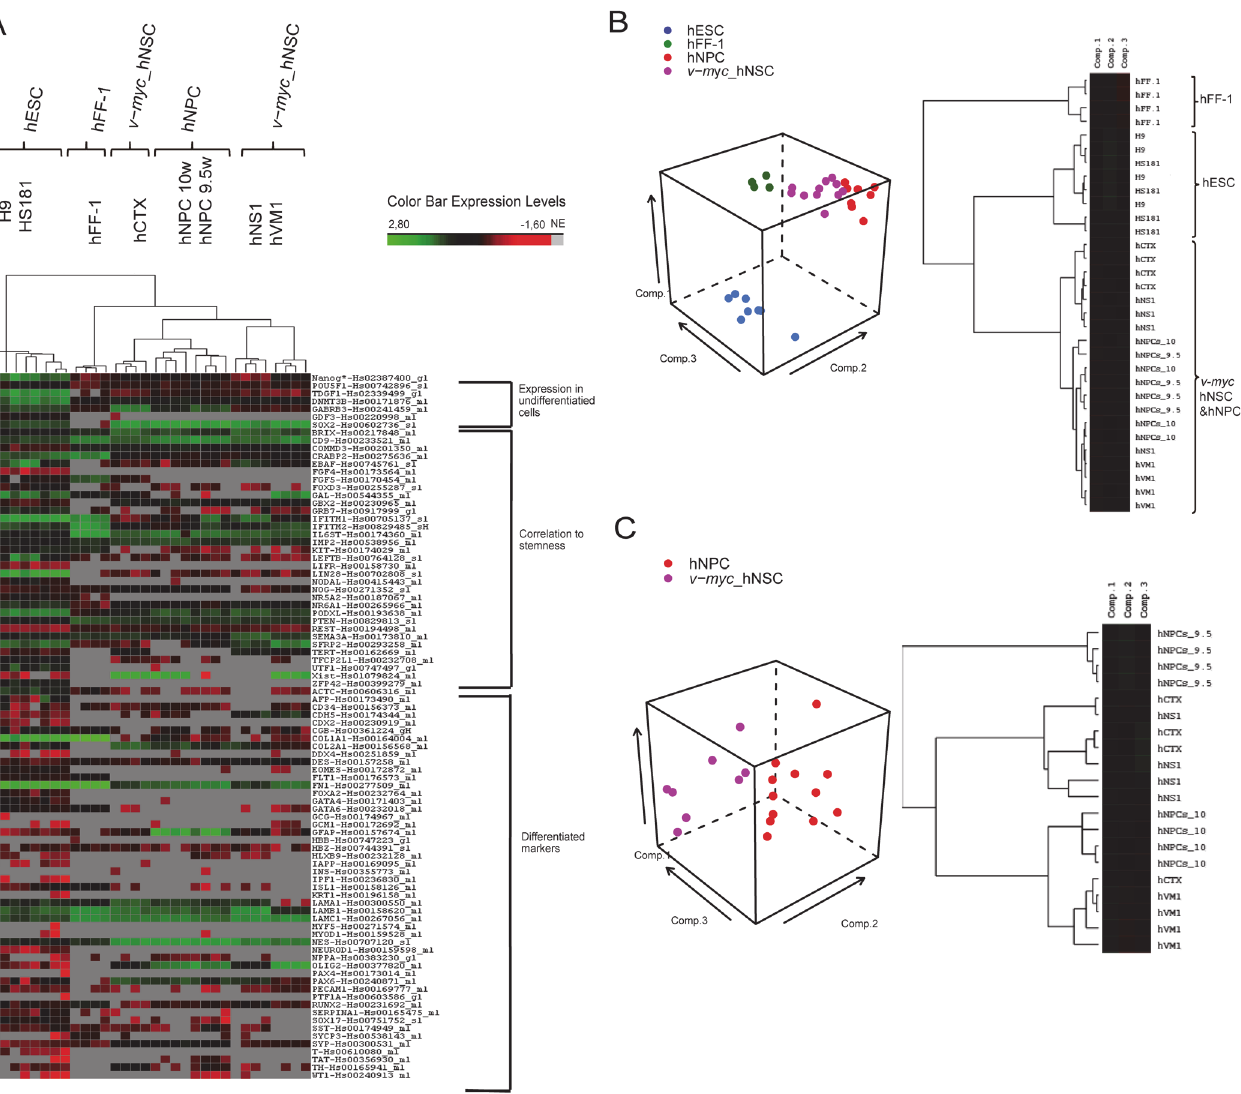
Fig 1. Gene expression pattern of the different cell lines, clustering and PCA analysis. A) The array data were normalized and a hierarchical clustering was run. On top of the heatmap, the dendrogram shows the clustering among the different samples. The classified list of the genes under study appears on the right side of the heatmap. The Color Bar Expression Levels show the differences in gene expression: black means no differences, green means a high expression, and red means low expression. Grey color mean No Expression (NE). B) Human Stem Cell Pluripotency Array (TaqMan) gene expression data from the different studied cell lines were subjected to a PCA. The graph presents the first, second and third components. For every cell line, the dots represent the value of each sample. To confirm the results of the PCA, a clustering analysis with the dataset of the components was done (right side of the panel). C) PCA analysis of v-myc immortalized cells and non-immortalized hNPCs and the clustering of the PCA data to confirm the similarity between v-myc immortalized and the hNPCs neurospheres according to the three